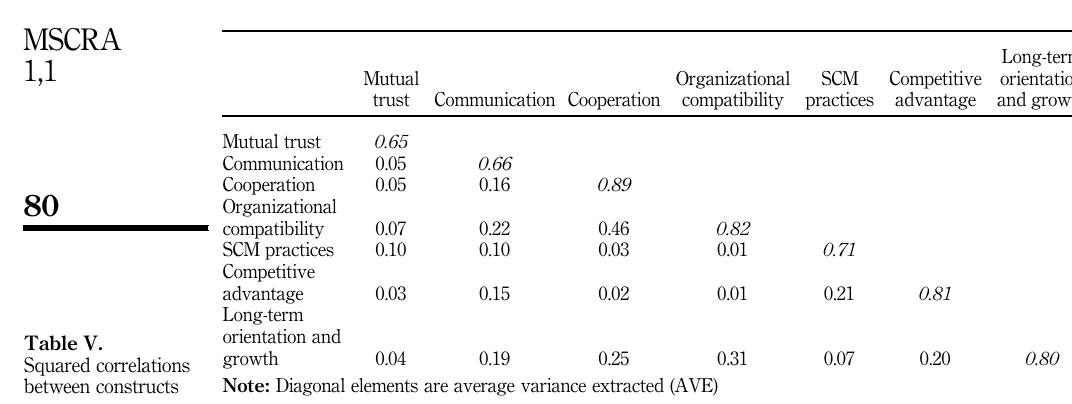
Table V. Squared correlations between constructs